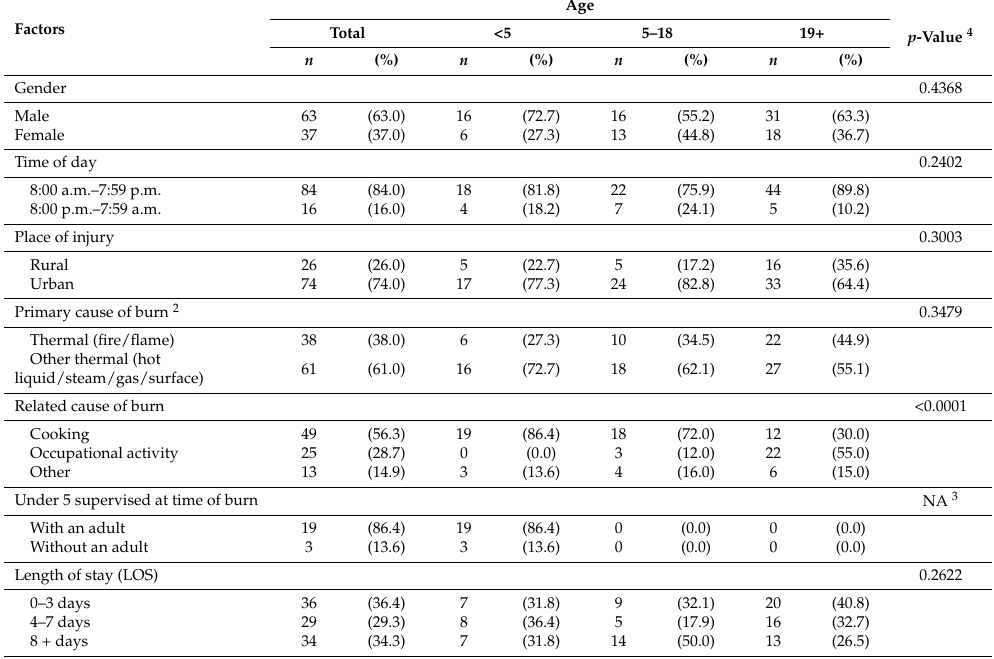
Table 1. Burn event factors by age 1 .